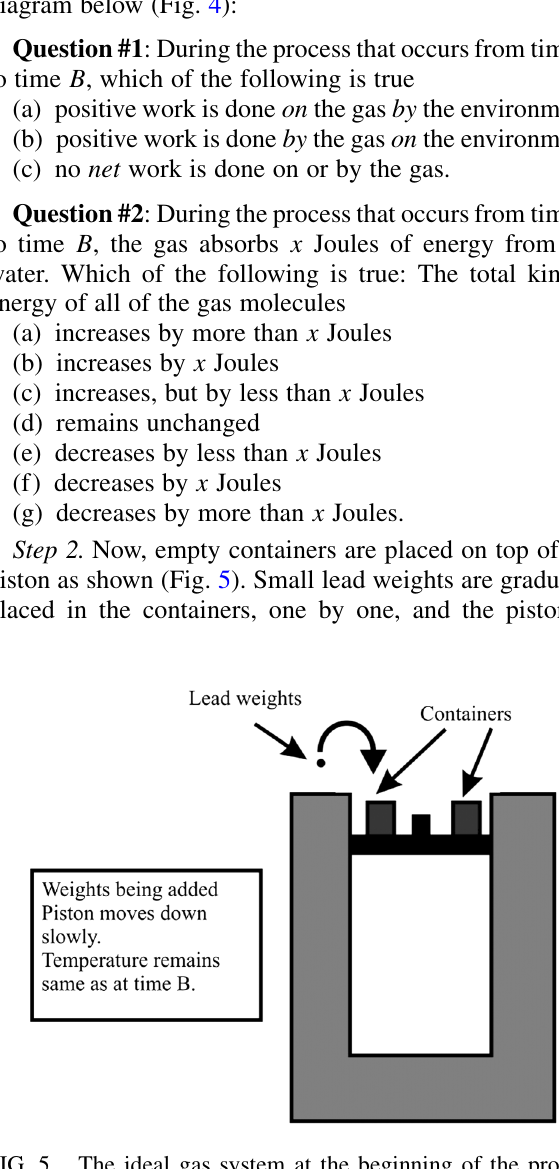
FIG. 5. The ideal gas system at the beginning of the process from time B to time C.